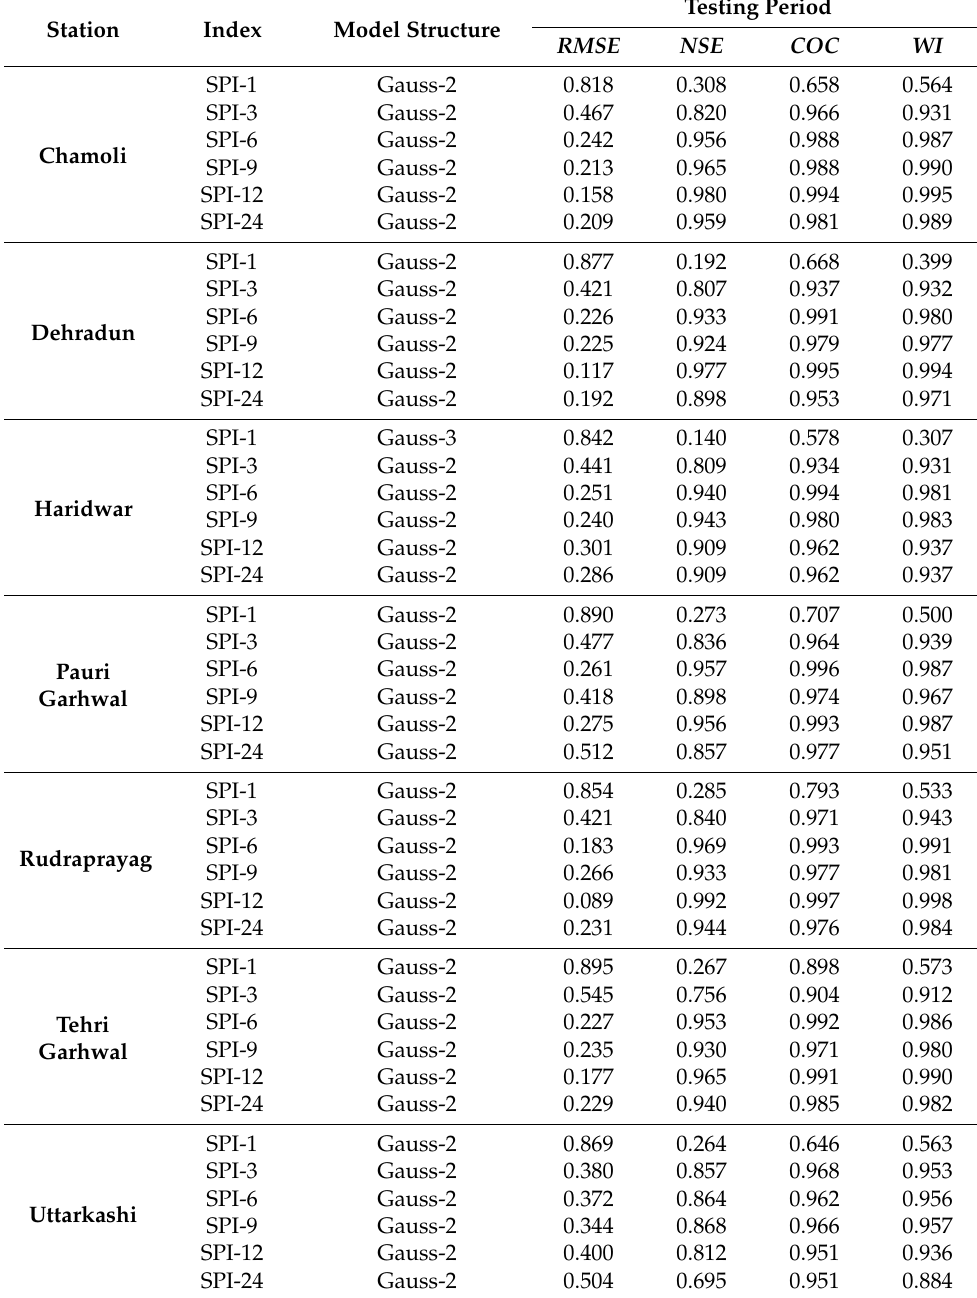
Table 4. Performance of CANFIS model at study stations.